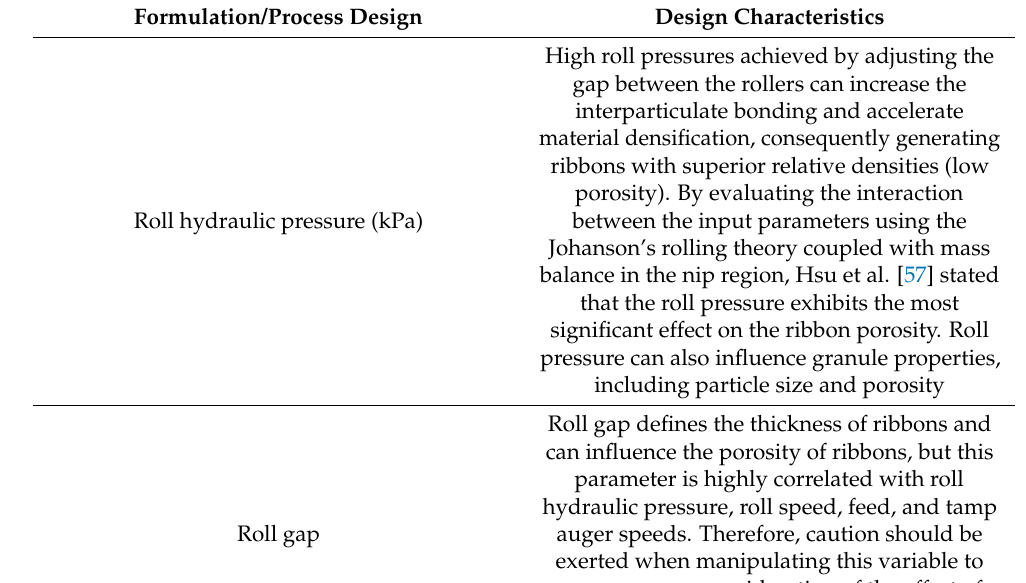
Table 3. General process design targeting granule properties in dry granulation using the roll compaction